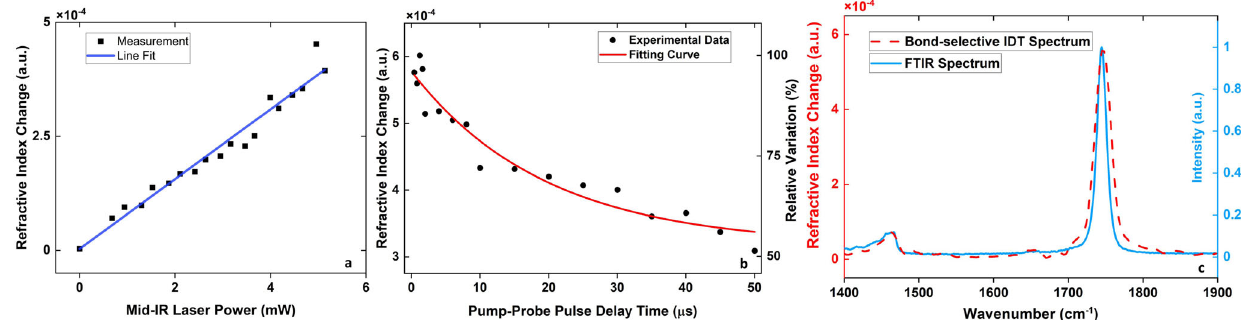
Fig.2 |BS-IDT system performance.a Dependence ofMIP-inducedRIchangeson mid-IR laser power and the linear fi tting curve with a slope of 7.7×10 − 5 . b MIP- induced RI changes and relative RI change with respect to the pump-probe time delayvariations.RelativeRIvariationisobtainedbydividingtheRIchangeoverthe